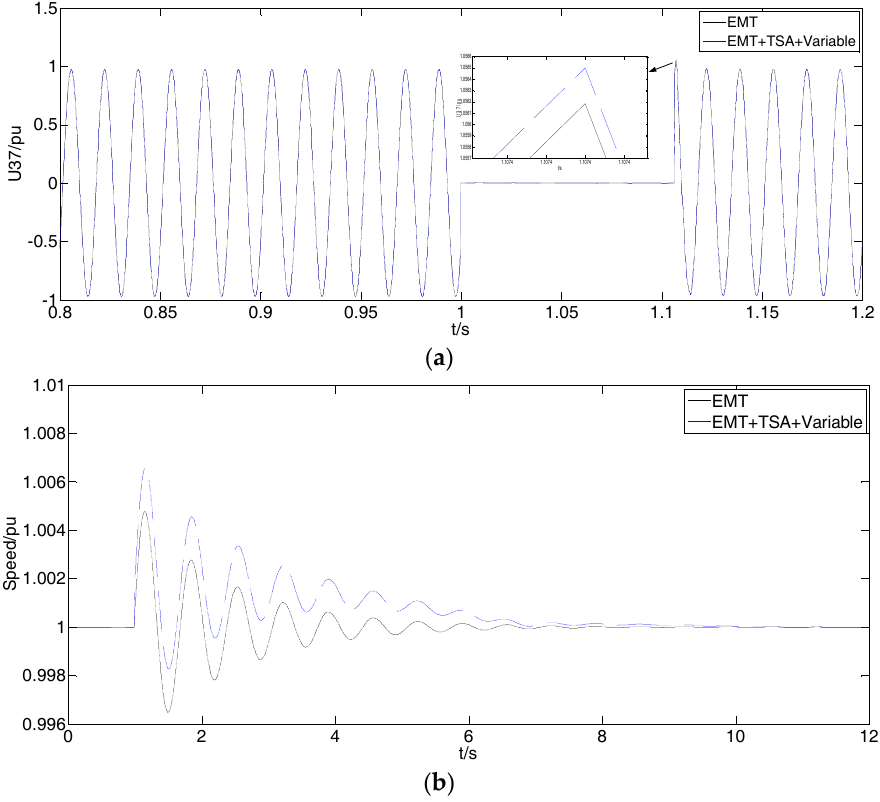
Figure 6. Comparison of simulation accuracy under case one. ( a ) Phase A voltage at bus 37 under case one; and, ( b ) Rotor speed of generator at bus 34 under case one.